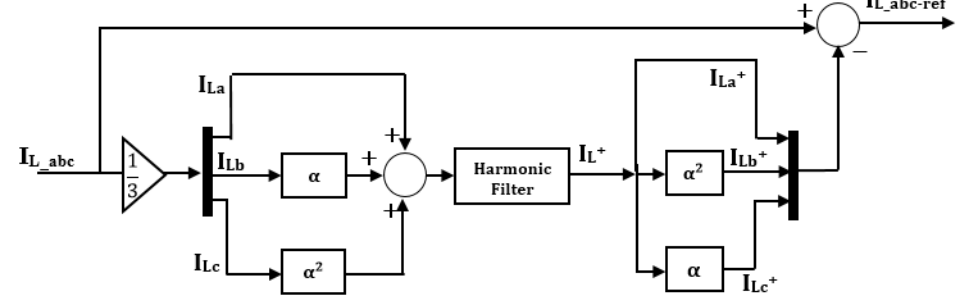
Figure 2. Block diagram of the proposed current reference algorithm.